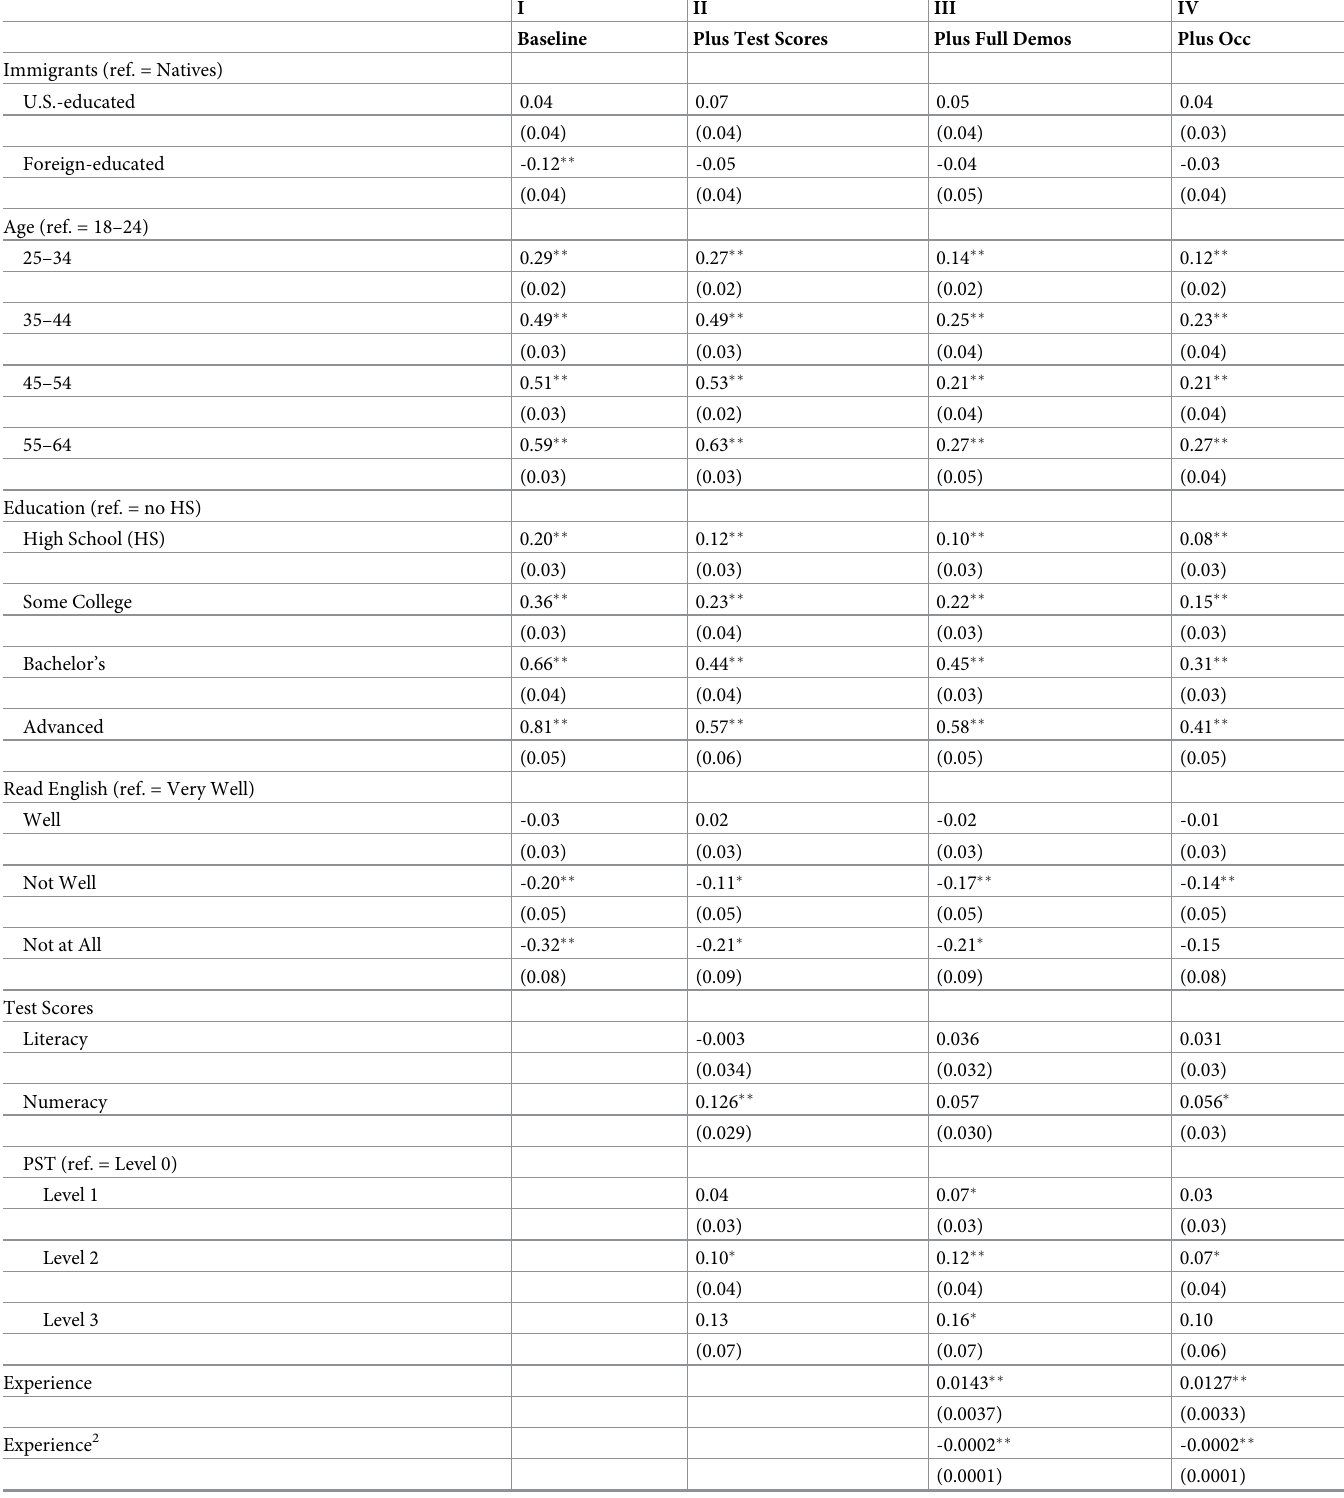
Table 6. Effect of controlling for test scores on the immigrant-native wage